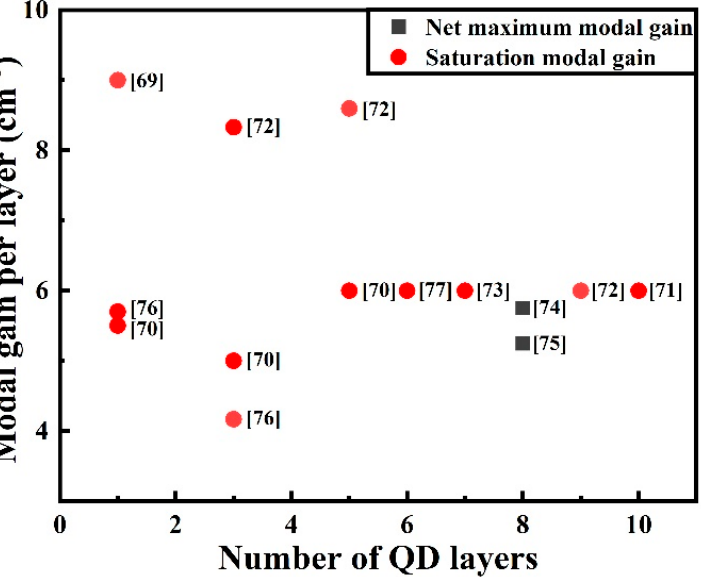
Figure 9. Modal gain of QD lasers calculated per layer in relation to the number of QD layers. Temperature insensitivity is an obvious characteristic of QD laser superiority over QW lasers; so, it is necessary to investigate the temperature-dependent properties of QDs, especially for the applications in a long wavelength, because the lower confining potential and the smaller energy spacing between the GS and the first ES will reduce the thermal stability. As shown in Figure 10a,b, the temperature-dependent photoluminescence (PL) spectra of undoped as-grown QDs (QDU) and p-doped as-grown QDs (QDP) are measured at the temperature range from 4 to 300 K